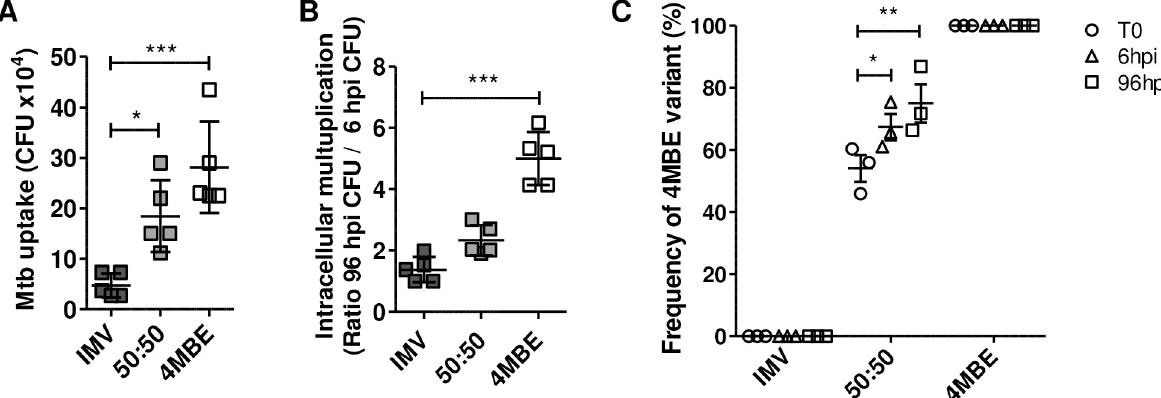
Fig 5. Improved Mtb intra-macrophagic survival of the 4MBE variant. Macrophages were infected by the IMV (black), the 4MBE variant (white) or a half-half mixture (50:50, grey) at a multiplicity of infection (MOI) of 10:1. (A-B) At 6 and 96 hours post-infection (hpi), macrophages were lysed for intracellular CFU counting to study (A) Mtb uptake by macrophages thanks to intracellular CFU counting at 6 hpi and (B) intracellular multiplication thanks to intracellular CFU ratio between 6 hpi and 96 hpi. (C) The change in the 4MBE variant frequency on plated bacteria was assessed by ddPCR as described in the Material and Methods section. Values for each condition are the mean ± SD of three to five independent experiments. Means were compared using One-Way ANOVA followed by Bonferroni correction. � p < 0.05, �� p < 0.01, ��� p < 0.001.